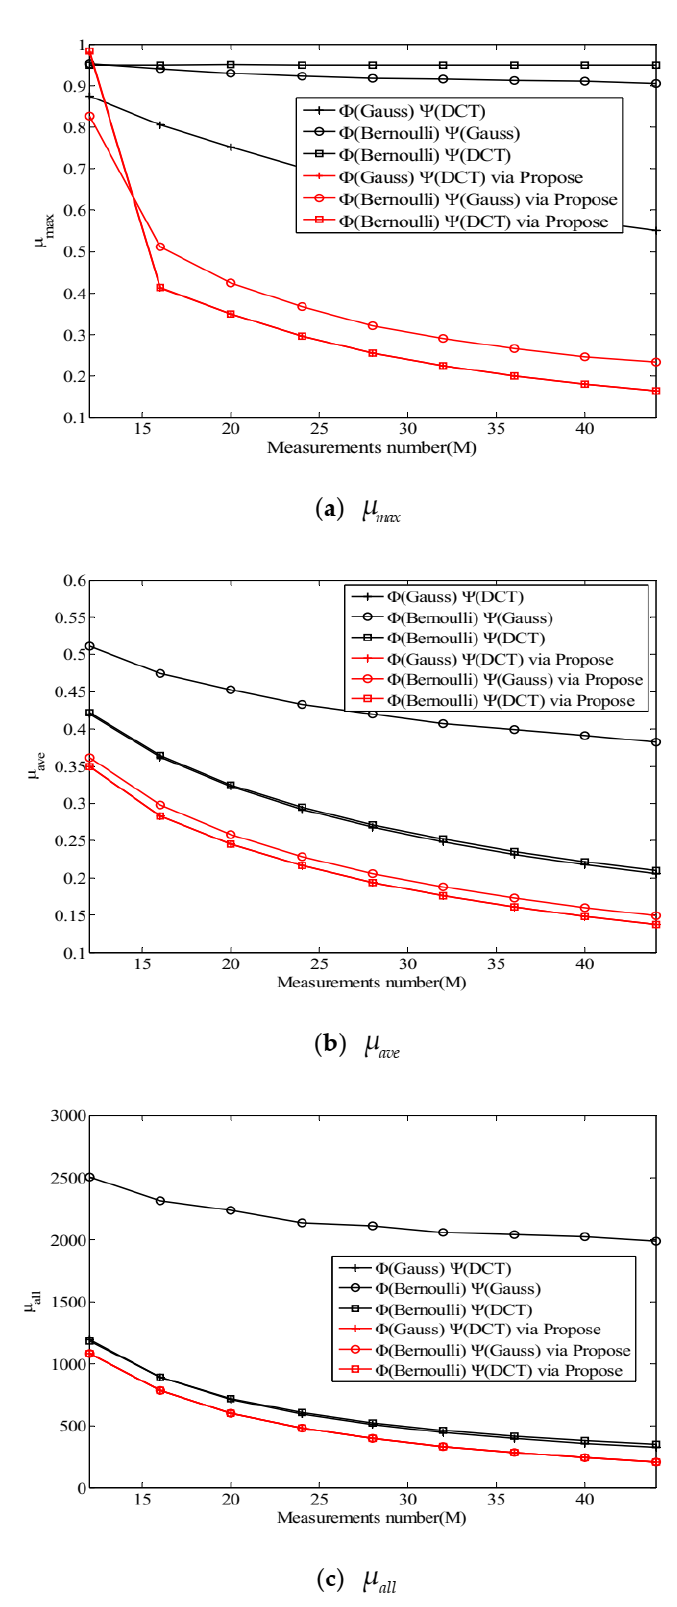
Figure 7. The evolution of ( a ) µ max , ( b ) µ ave and ( c ) µ all , all versus measurements number with different D